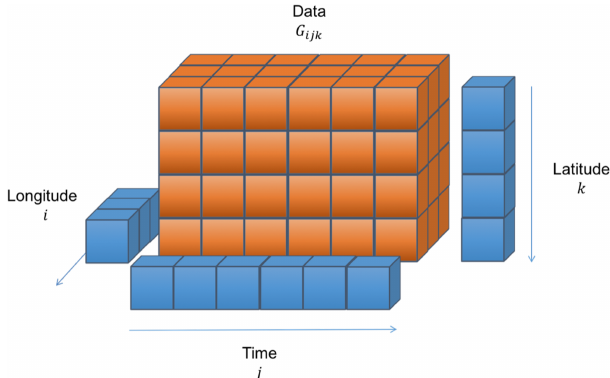
Figure A1. A regular spatio-temporal grid in time, longitude and latitude. Such a grid is used for the aggregation operation that is at the heart of the collocation procedure used in this paper. Grid boxes may either contain data or be empty. Reproduced from Watson- Parris et al. (2016).